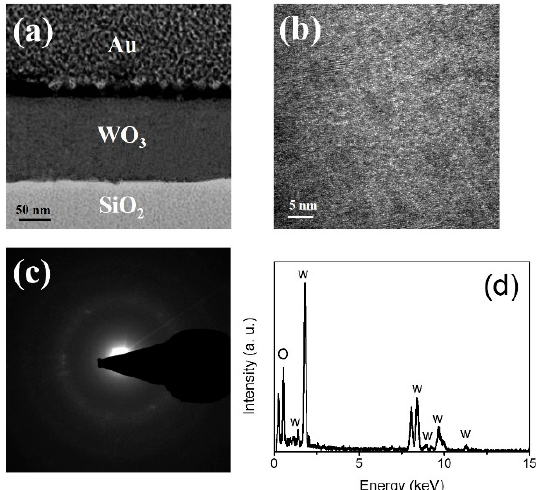
Figure 4. TEM analysis of the as-grown WO 3 film: ( a ) low-magnification image, ( b ) high-resolution image, ( c ) SAED pattern, ( d ) EDS spectra.